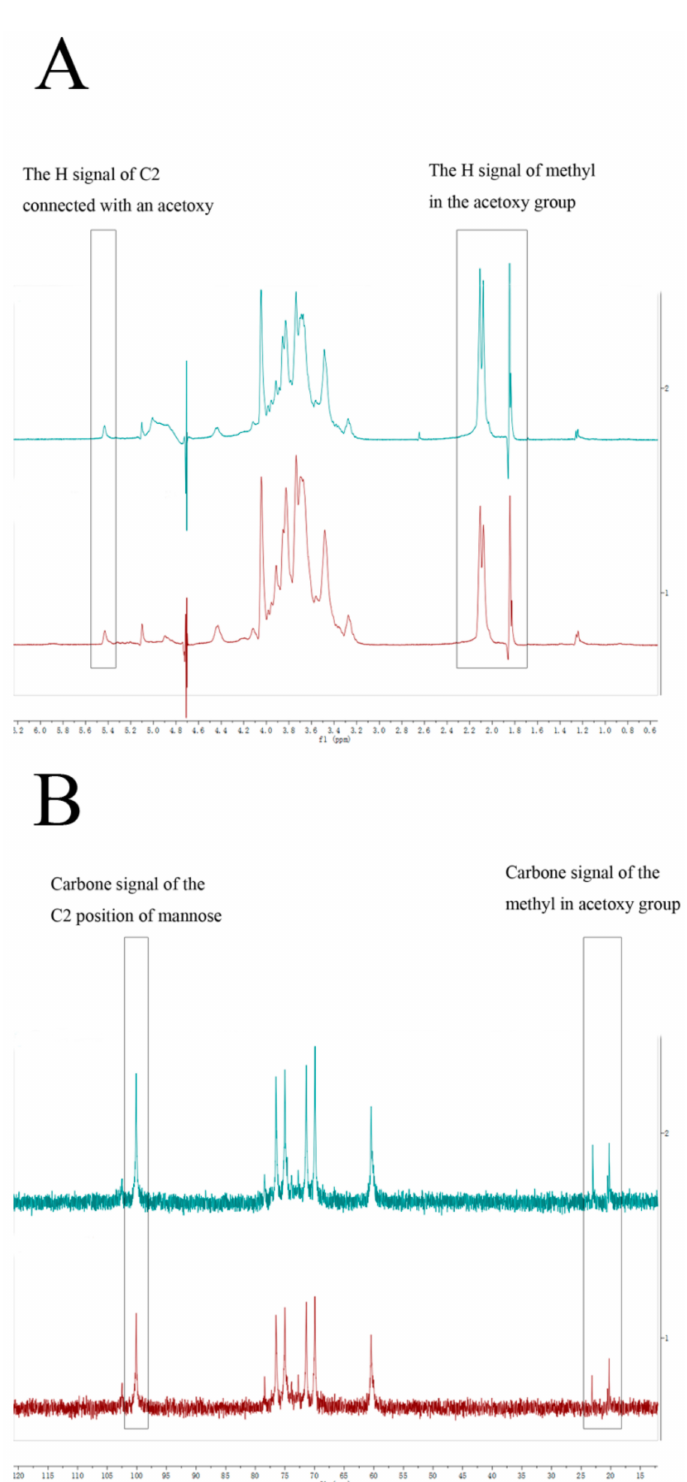
Figure 3. The ( A ) 1 H-NMR spectra of DWDOP1 and FWDOP1; the ( B ) 13 C spectra of DWDOP1 and